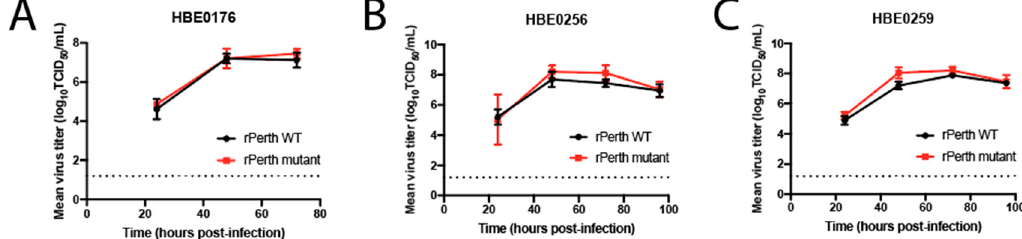
Figure 2. In vitro replication of rPerth WT and HA mutant in human bronchiole epithelial (HBE) cells. Cells from three different patient cell lines, ( A ) HBE0176, ( B ) HBE0256, and ( C ) HBE0259, were infected at 10 3 TCID 50 per well with rPerth WT (black circles) or rPerth mutant (red squares). The apical supernatant was collected at the indicated time points and virus titers were determined on MDCK cells using TCID 50 assays. The experiments were performed in triplicate.